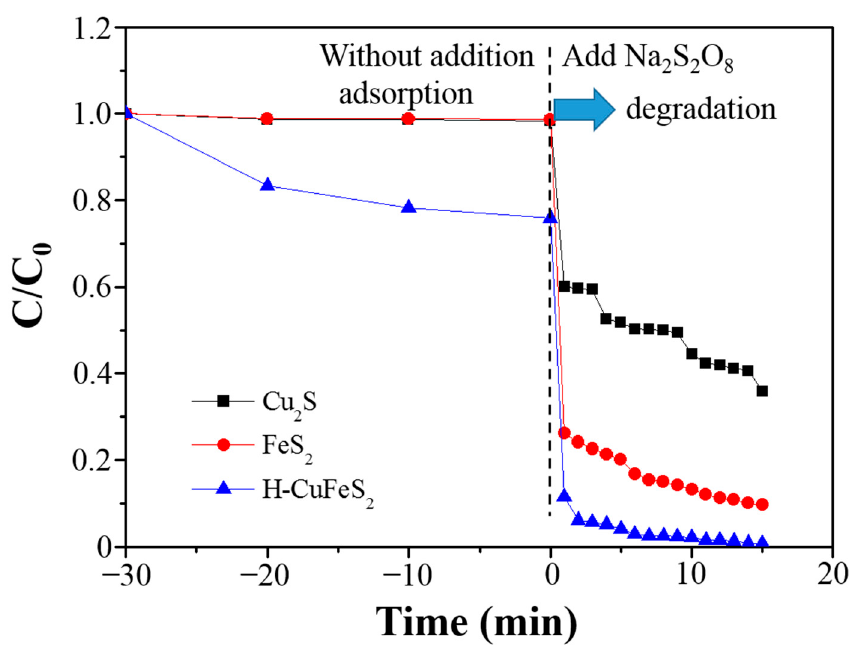
Figure 9. Fenton-like reaction for RhB degradation under different conditions: H-CuFeS 2 samples only (black), Na 2 S 2 O 8 only (red), and H-CuFeS 2 in the presence of Na 2 S 2 O 8 (blue). Top image: pho- tographs of the RhB solution under the Fenton reaction at different reaction time.